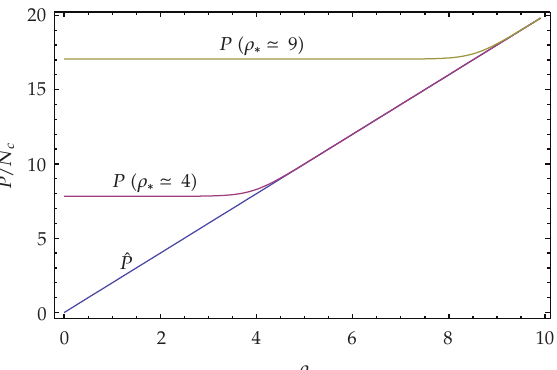
Figure 9: The numerical solutions for P (cid:5) ρ (cid:6) /N c used in the analysis as an example, for N c (cid:8) 100. The three (cid:17) solutions correspond to the P case with ρ ∗ (cid:8) 0, and to two new numerical solutions with, respectively, ρ ∗ (cid:9) 4 and ρ ∗ (cid:9) 9 (cid:3) 58 (cid:4)